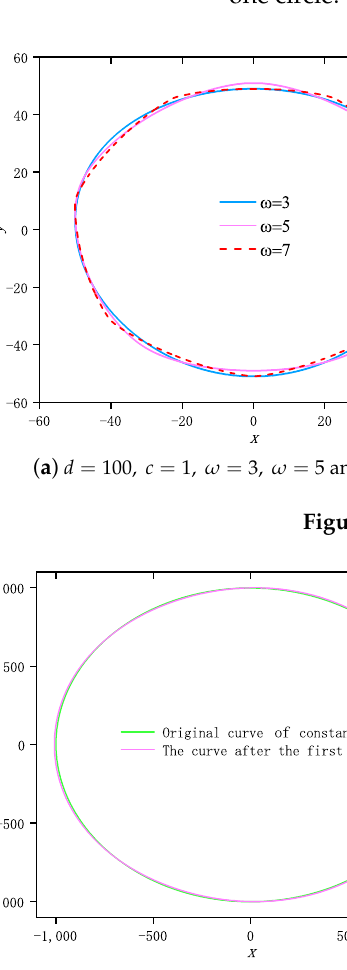
( a ) The original curve of constant width and the first derivative curve ( b ) The second and third derivative curves Figure 2. Trajectory curves with different number of derivatives ( d = 2000, c = 1, ω =